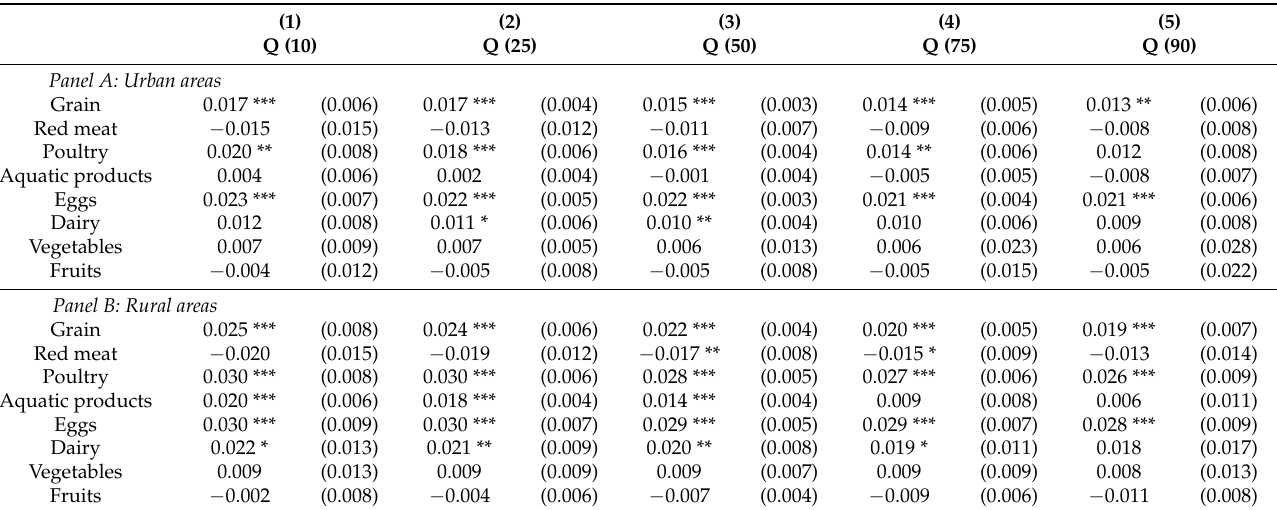
Table 6. Results of quantile regressions for panel data.